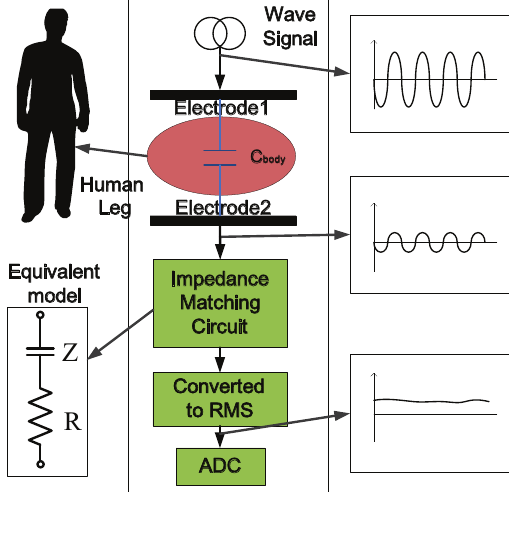
Figure 1. Design concept of the proposed capacitance-based sensing system for human locomotion recognition. The magnitude of the signal on the receiver electrode is influenced by the body movement. The signal was converted to root mean square (RMS) value before the analog-to-digital converter